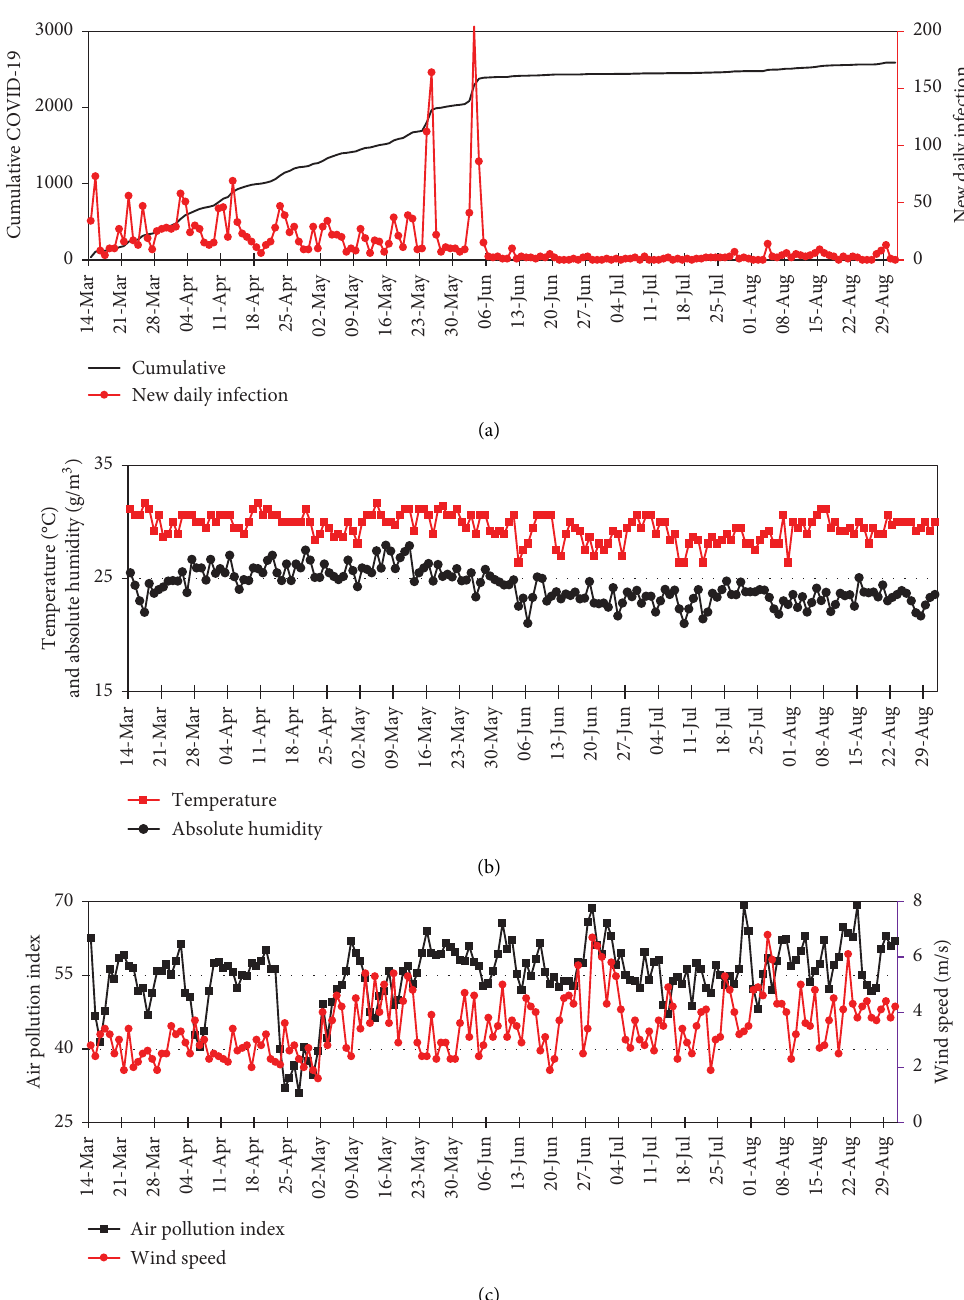
Figure 2: Daily variation of weather parameters and COVID-19 cases from 14 March to 31 August 2020 for Kuala Lumpur. (a) Cumulative and daily COVID-19 spread, (b) mean temperature and absolute humidity, and (c) wind speed and air pollution index.